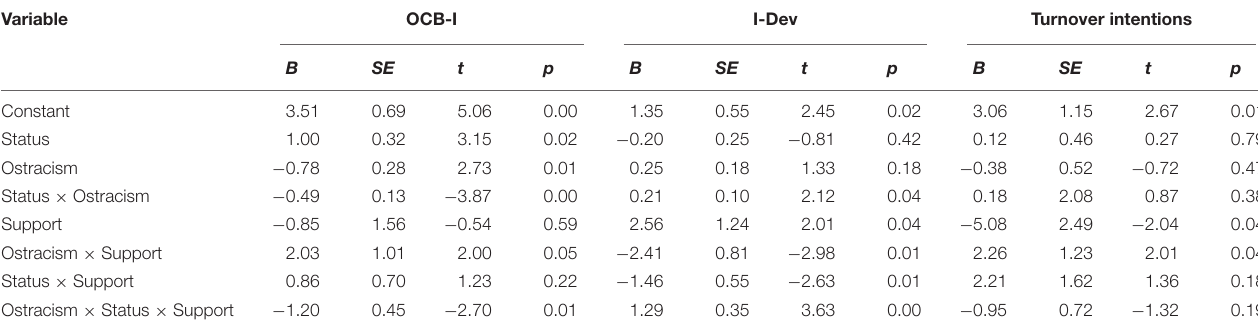
TABLE 5 | Study 2: Regression results for three-way interaction outcomes.